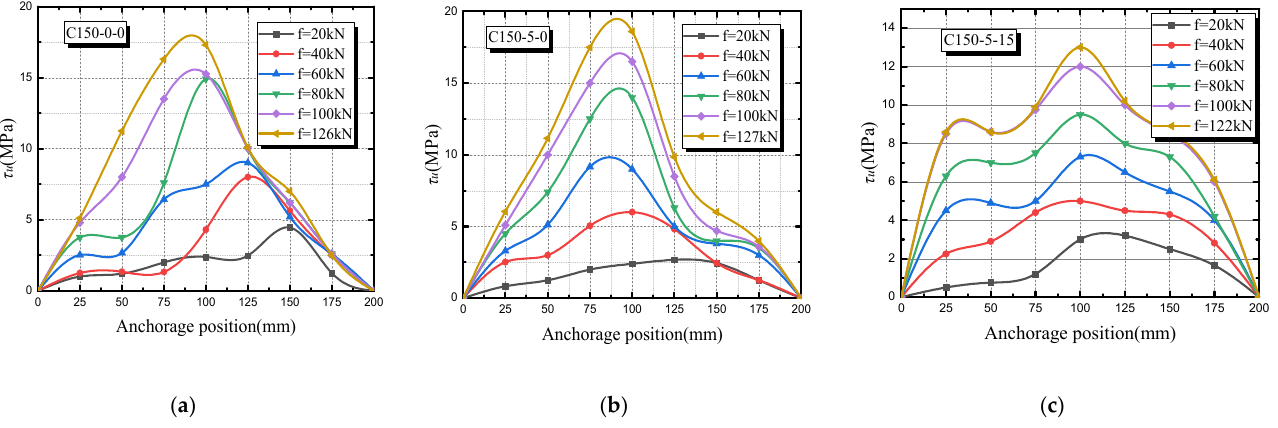
Figure 14. Bond stress-anchorage position relationship: ( a ) C150-0-0; ( b ) C150-5-0; ( c ) C150-5-15.